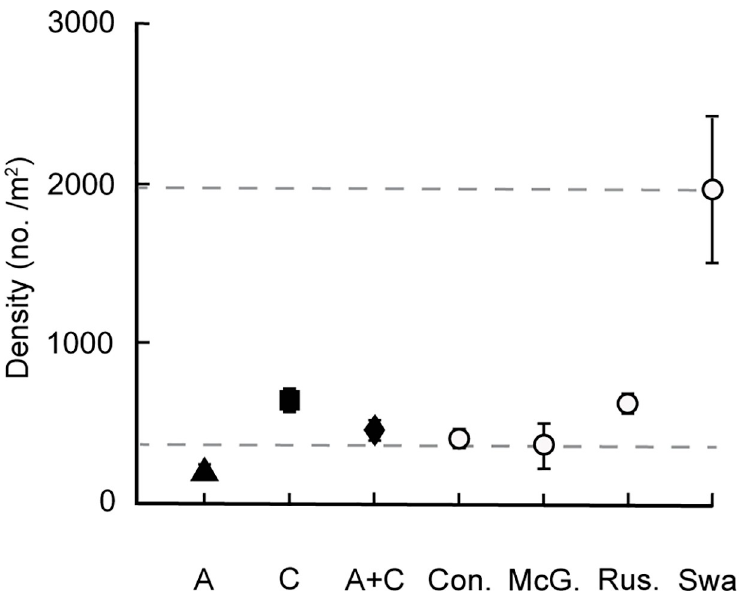
Fig 3. Caddisfly densities in the semi-natural experiment (solid symbols) for Arctopsyche monoculture (A), Ceratopsyche monoculture (C), and polyculture (A + C) treatments, and total caddisfly silk net densities in four streams (open symbols), including Convict (Con.), McGee (McG.), Rush (Rus.), and Swauger (Swa.) Creeks, near the SNARL field station in Mammoth Lakes, CA, USA. Values are means ± 1 SEM, and dashed lines represent the minimum and maximum mean larval caddisfly densities measured over three dates in each of the four streams.